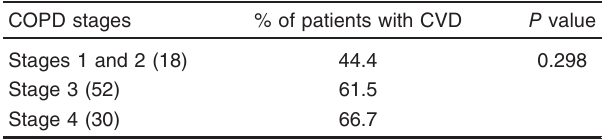
Table 2 Relation between severity of chronic obstructive pulmonary disease and prevalence of cardiovascular comorbidities